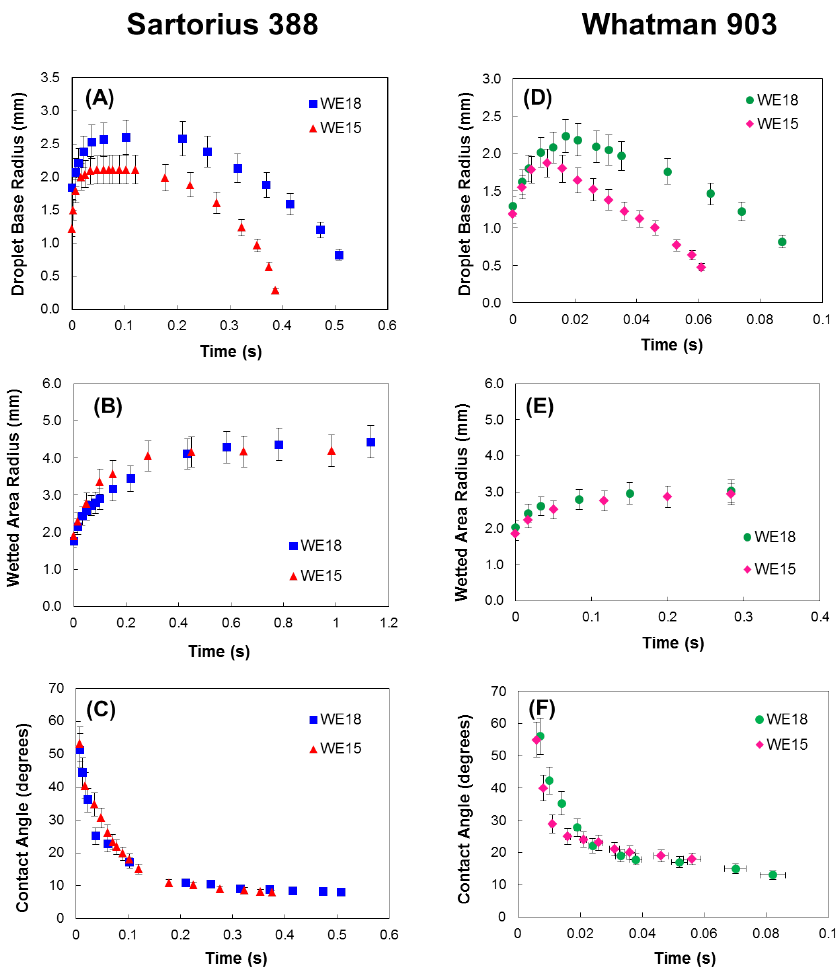
Figure 8. Evolution of the liquid cap base radius, the wetted area radius and the contact angle with time for the spreading of WE18 and WE15 droplets on Sartorius 388 ( A – C ) and Whatman 903 ( D – F